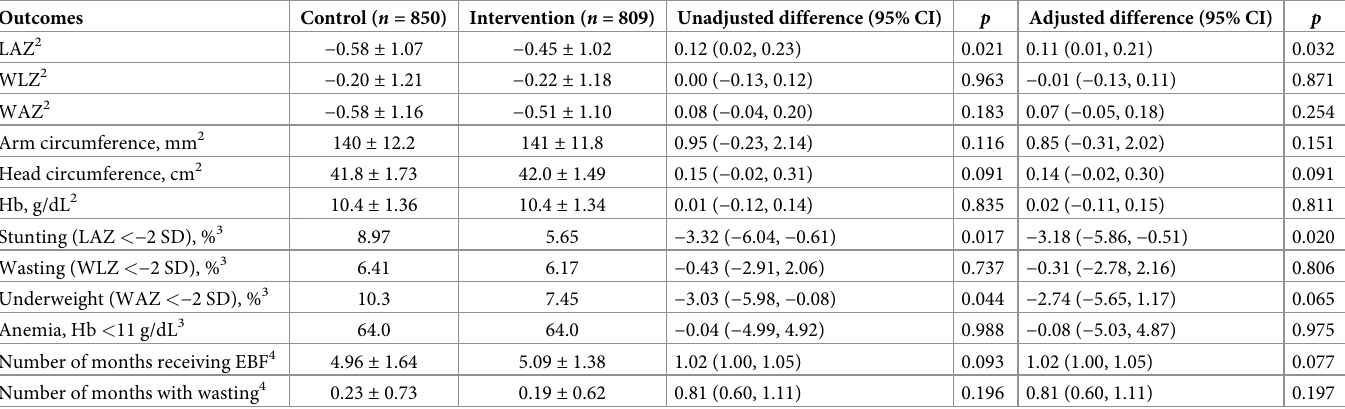
Table 3. Effect of maternal prenatal BEP supplementation on infant growth and nutritional status at 6 months 1